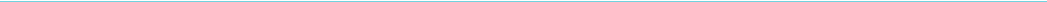
Figure 4: Mortality stratified by patients with and without comorbidities. Panel A shows a scatter plot with the circle representing all patients stratified by age and number of comorbidities. Blue circles represent survivors and red circles represent patients who died during the hospitali- sation. Panels B and C report the proportion of in-hospital mortality in patients without any (B) and with any (C) comorbidities stratified by